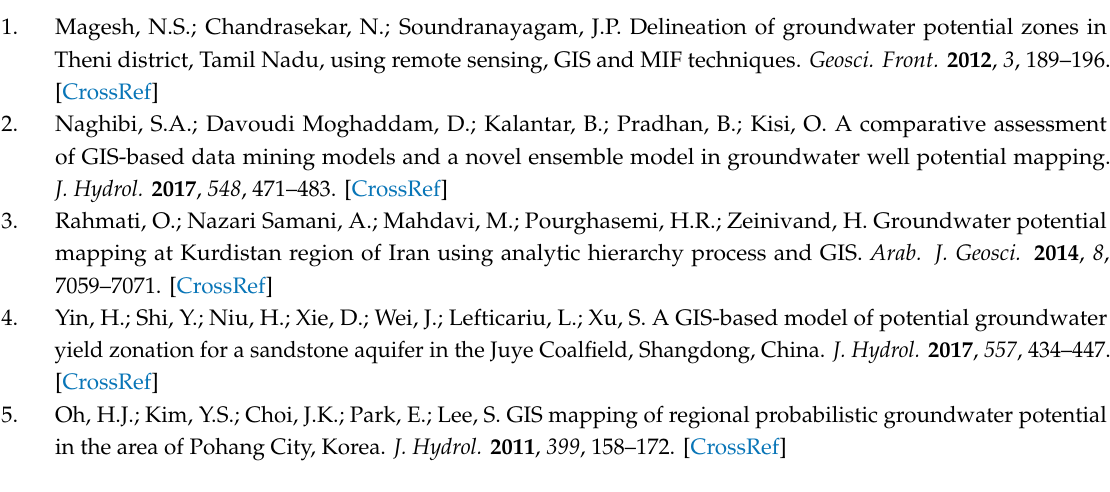
Figure S1: ROC curves of the training and validation steps for the RF model using dataset S1, Figure S2: ROC curves of the training and validation steps for the RF model using dataset S2, Figure S3: ROC curves of the training and validation steps for the RF model using dataset S3, Figure S4: ROC curves of the training and validation steps for the GARP model using dataset S1, Figure S5: ROC curves of the training and validation steps for the GARP model using dataset S2, Figure S6: ROC curves of the training and validation steps for the GARP model using dataset S3, Figure S7: ROC curves of the training and validation steps for the QUEST model using dataset S1, Figure S8: ROC curves of the training and validation steps for the QUEST model using dataset S2, Figure S9: ROC curves of the training and validation steps for the QUEST model using dataset